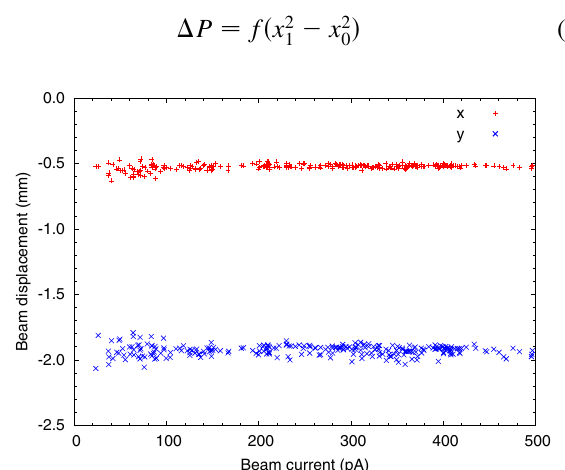
FIG. 8. Averaged beam position data vs beam intensity. Some of the scattering above 100 pA is mostly due to unstable beam extraction conditions. At low beam currents, resolution and reproducibility of the position measurement is limited due to noise and other imperfections.